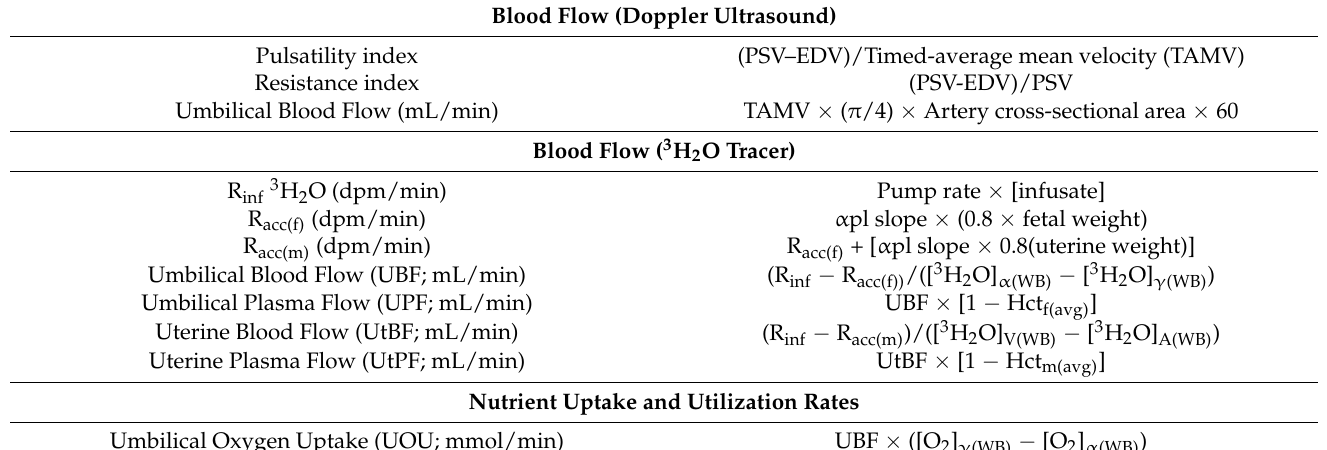
Table 1. Calculations 1 for blood flow, nutrient uptake, nutrient utilization, and quotients. Blood Flow (Doppler